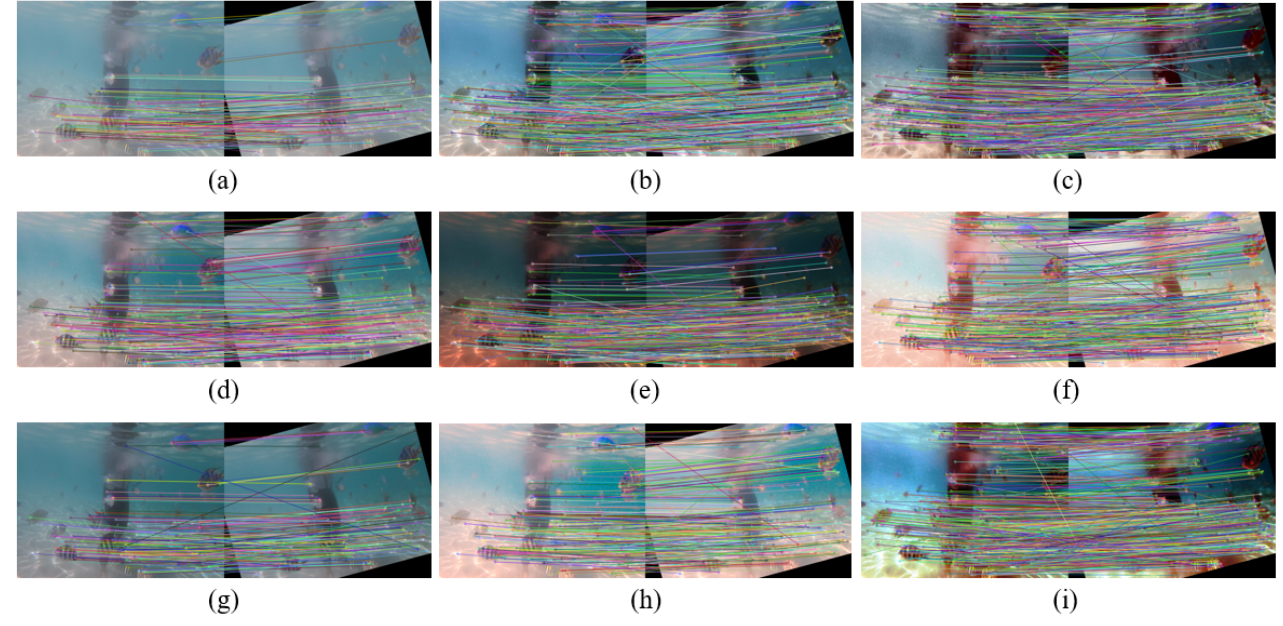
Figure 8. An example of feature-point matching. We match an underwater image with its rotated version using SIFT[48] to demonstrate how an image enhancement helps improve the image’s quality and increase the matching feature points. ( a ) Original underwater image pair, and its enhanced version using ( b ) Fusion-based[43], ( c ) Retinex-based[44], ( d ) IBLA[10], ( e ) AGC[45], ( f ) GDCP[9],